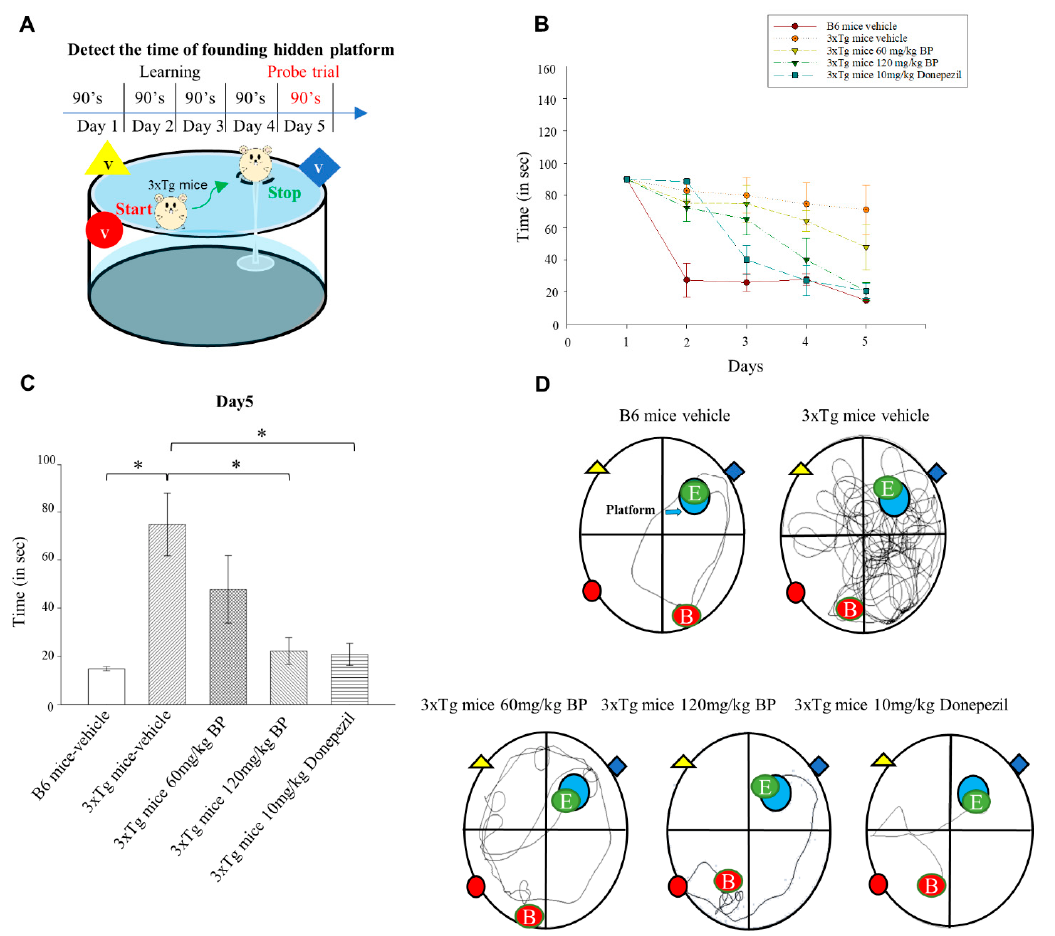
Figure 5. BP ameliorates spatial learning and memory in 3×Tg AD mice. ( A ) We have trained the B6 mice and 3xTg mice to find the platforms hidden in the water. Our training time is five days, 90s each time, once a day. s: second ( B ) The time spent to reach the platform in each group on Day 1 to Day 5. ( C ) Time spent in the target quadrant during the test for each group on Day 5. Time spent in the target: B6 mice—vehicle = 14.86s ± 1.49, 3xTg mice—vehicle = 74.74s ± 23.83, n = 6; 60 mg/kg BP- treated 3xTg mice = 47.84s ± 25.69, n = 4; 120 mg/kg BP-treated 3xTg mice = 22.22s ± 10.14, n = 6; 10 mg/kg treated 3xTg mice = 20.83s ± 8, n = 4. * p < 0.05. ( D ) Representative swimming route map of each group on the last day of training. Red dot, the starting point of the swim; green dot, the end point of the swim. The marker of the red circle, yellow triangle, and blue diamond are visual cues.